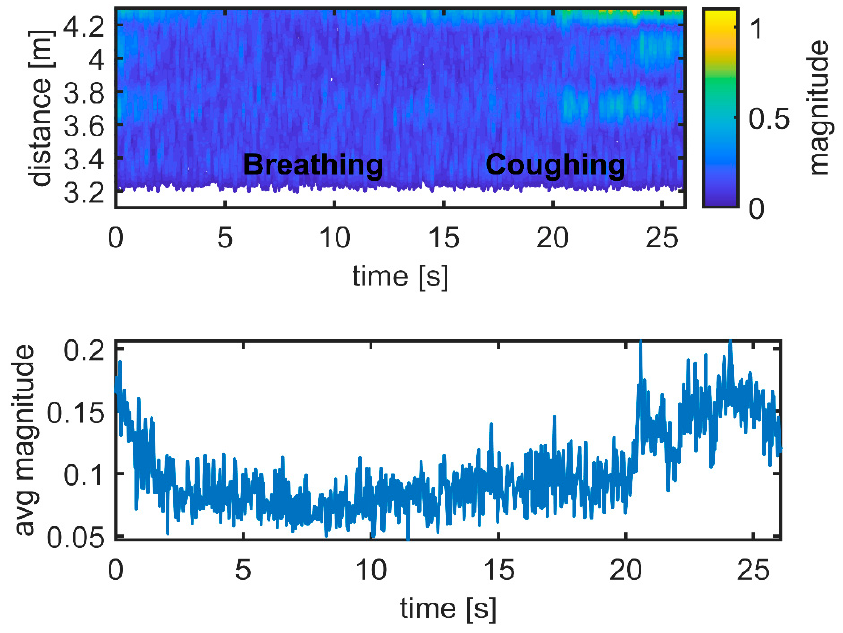
Figure 12. Respiration and coughing. Experimental results: lying down. Magnitude unit [ µ V] is normalized.